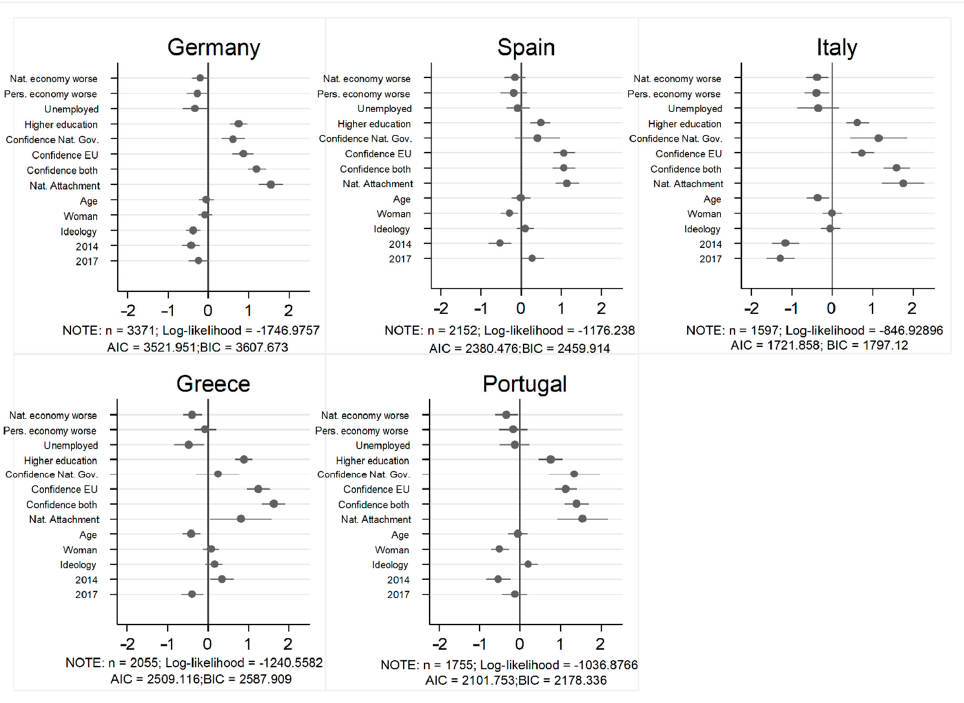
Figure 4. Coefficients of the logistic regression base model on attachment to Europe in Germany, Spain, Italy, Greece and Portugal. Source: Own elaboration from Eurobarometer Note: Logistic regression results. Variables standardized in each country. Crossing the zero line indicates that the differences are not statistically significant.